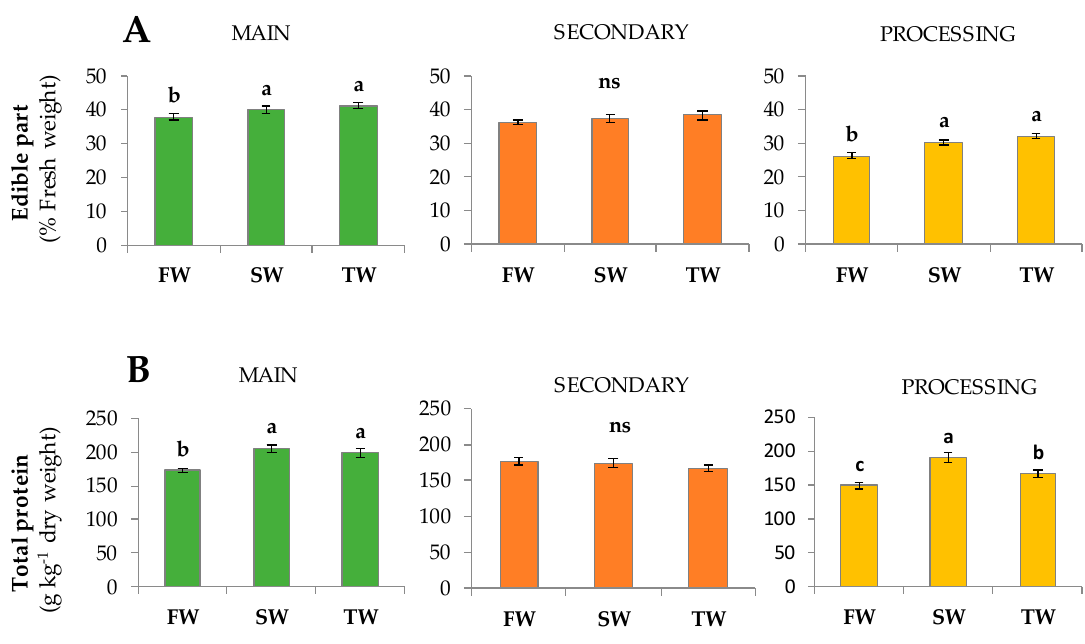
Figure 1. Effects of water irrigation treatments on percentage edible part ( A ) and protein content ( B ) of artichoke head. For each fraction (main, secondary, and processing), different superscript letters indicate statistically significant differences ( P ≤ 0.05) and ns, not significant ( P ≥ 0.05), according to Tukey’s test. Vertical bars indicate standard errors of three replicates. FW, fresh water; SW, secondary wastewater; TW, tertiary wastewater.